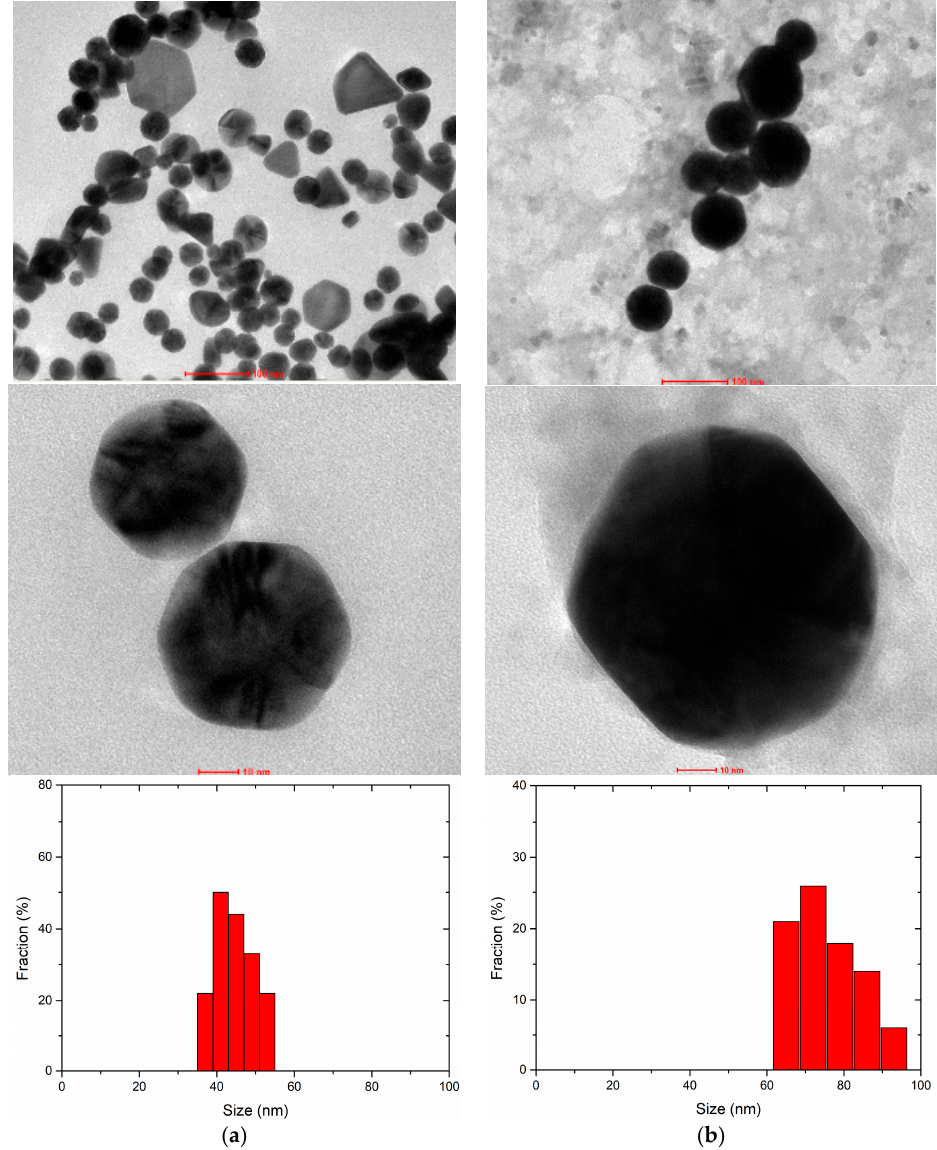
Figure 13. HRTEM images and size distributions of gold nanoparticles obtained: ( a ) with and; ( b ) without microwave treatment.